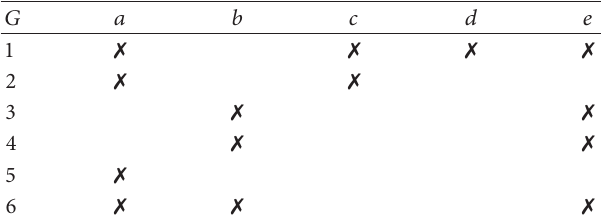
Table 1: A formal context (𝐺, 𝑀, 𝐼)